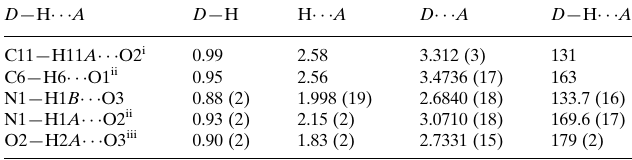
Hydrogen-bond geometry (A˚ , (cid:2)